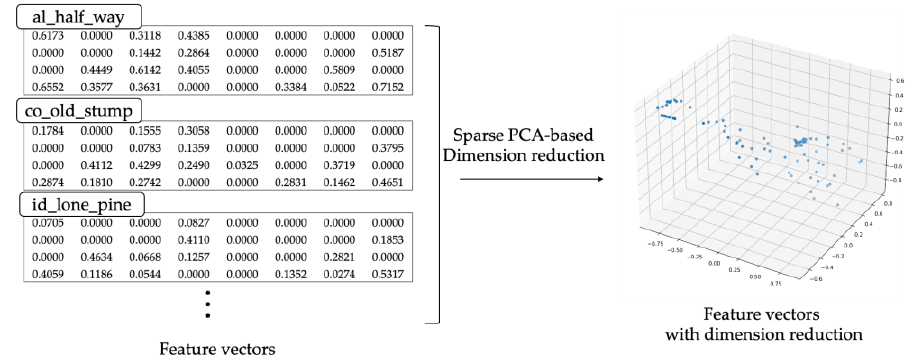
Figure 8. An example of sparse PCA-based dimension reduction in the wildfire dataset.